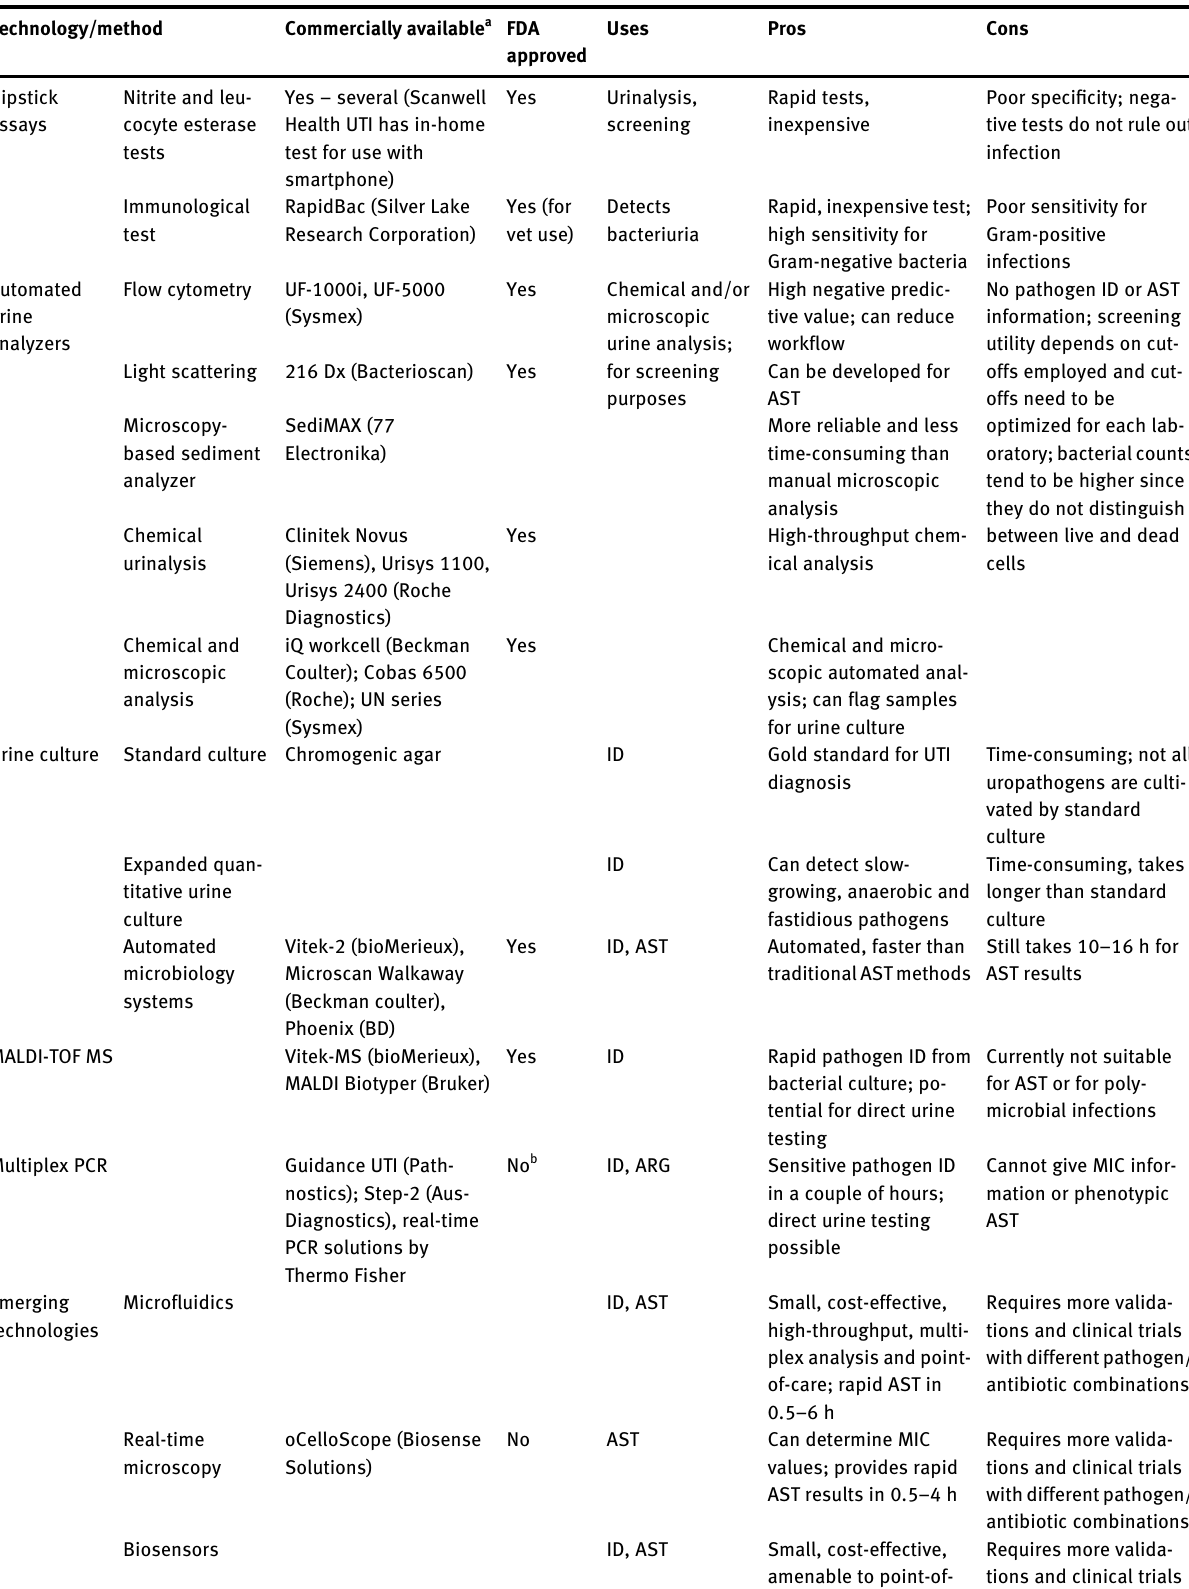
Table  : Technologies used in laboratory diagnosis of UTIs.